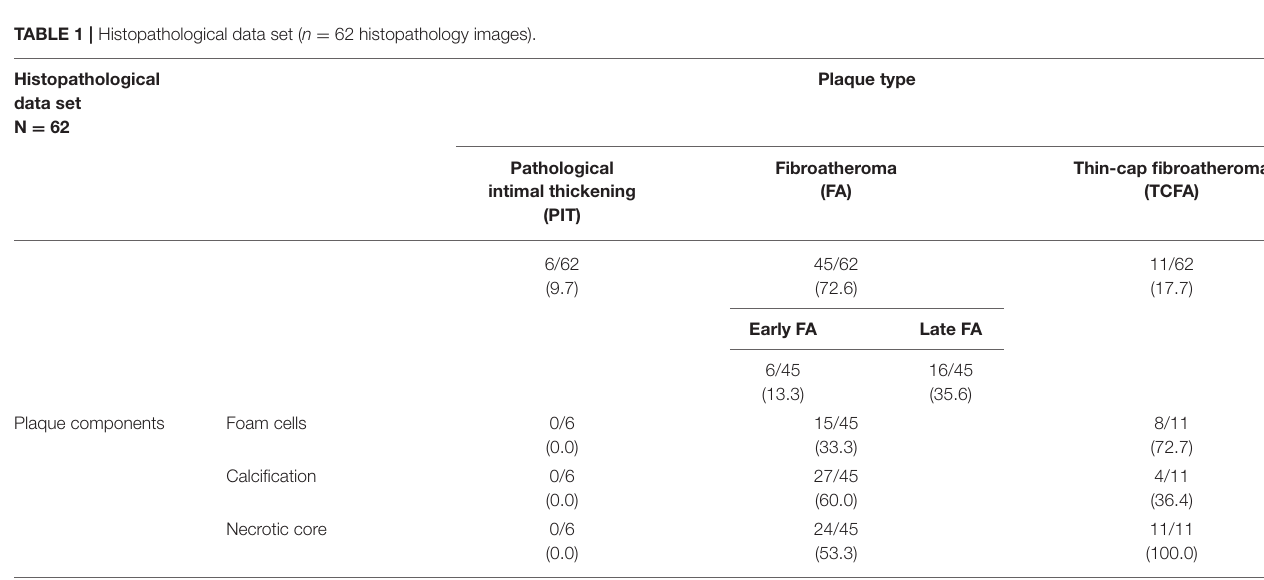
FIGURE 1 | DeepAD for prediction of atherosclerotic lesions from OCT. (A) Two data sets were used for training DeepAD: 222 OCT frames from 51 patients with manual annotations based on clinical expertise, and 62 OCT frames from 7 patients with annotations based on co-registered histopathology. (B) DeepAD learned to accurately predict atherosclerotic lesions from OCT images and was evaluated on patients with histopathology-based annotations.